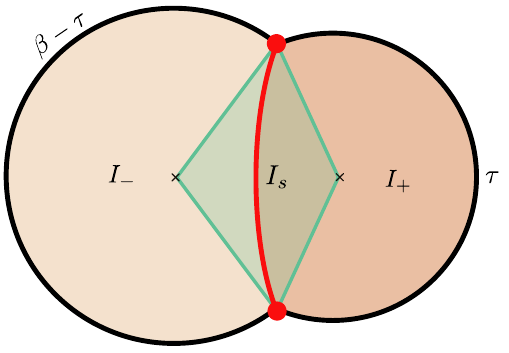
Figure 2 . The different regions in the decomposition of the gravitational action I [ X ] . The green region X s accounts for the intrinsic contribution from the